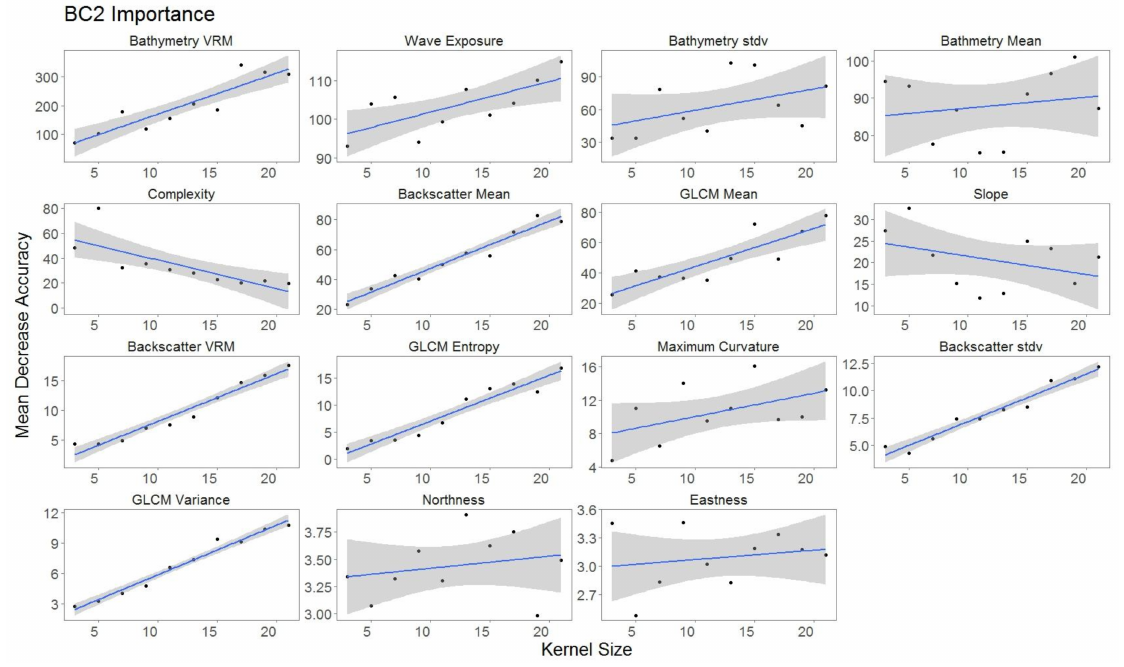
Figure A1. Variable importance BC2 sorted by derivatives in order of importance. GLM trend represented in blue. Gray area represents 95% confidence interval for predictions.